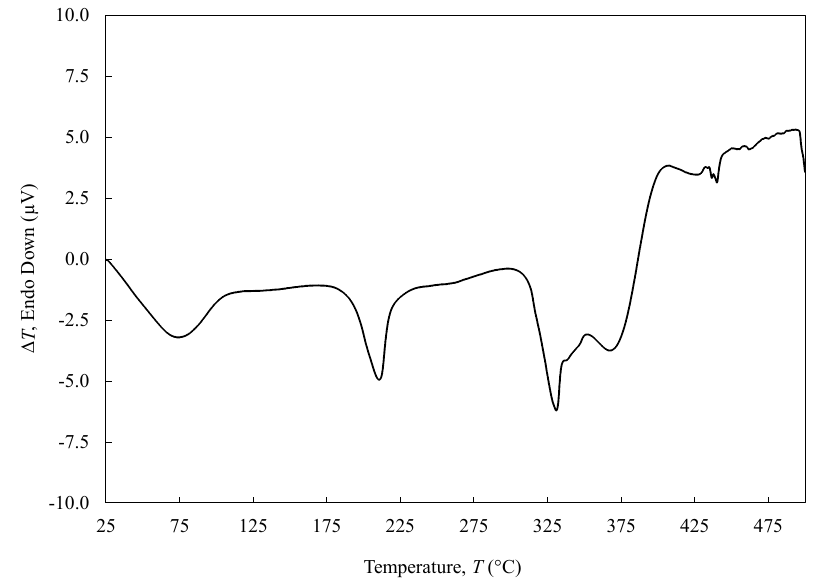
Figure 6. DTA of 1Y PVA from 25 to 500 °C.